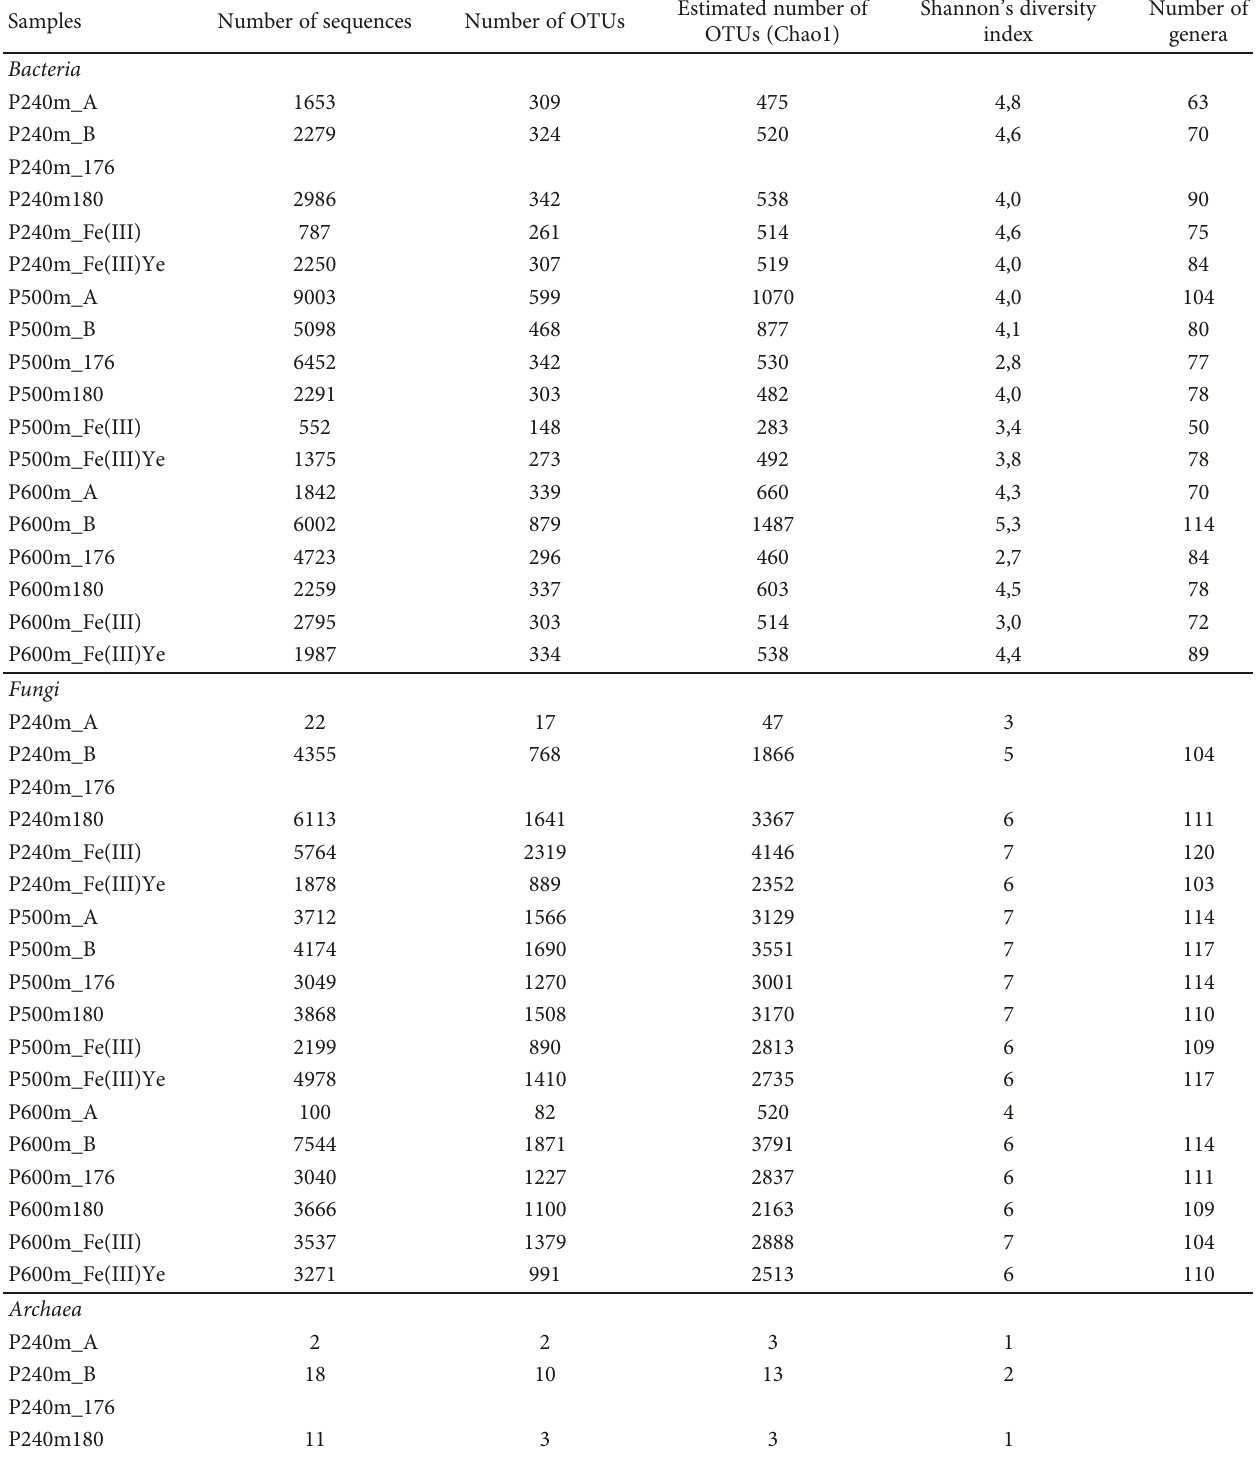
Table 3: The number of sequences, OTUs, Chao1 estimated number of OTUs, Shannon ’ s diversity index, and number of identi fi ed genera of the bacteria, fungi, and archaea found in the original mine water samples and enrichments. The values in grey indicate that only low numbers of sequence reads were obtained and the data was excluded from the analyses. The sample name abbreviations are as follows; P =Pyhäsalmi; 240m, 500m, 600 m=depth; A, B=sample replicate A or B; 176=ferrous iron-containing medium 176; 180=ferrous iron-containing medium 180; Fe(III) =ferric iron containing growth medium; Ye=Yeast extract containing growth